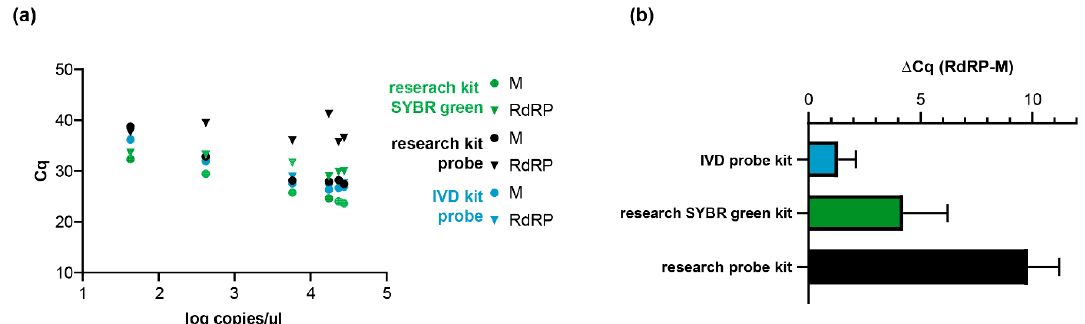
Figure 3. SARS-CoV-2 RNA detection in patient samples detection using M- versus RdRP-specific primers. ( a ) Comparison of M- and RdRP-specific primers and probes measured with the indicated one step qRT-PCR kits. ( b ) Mean values of the Cq difference between RdRP- and M-gene PCR. Cq, quantification cycle. Only samples positive in all assays are shown ( n = 6).